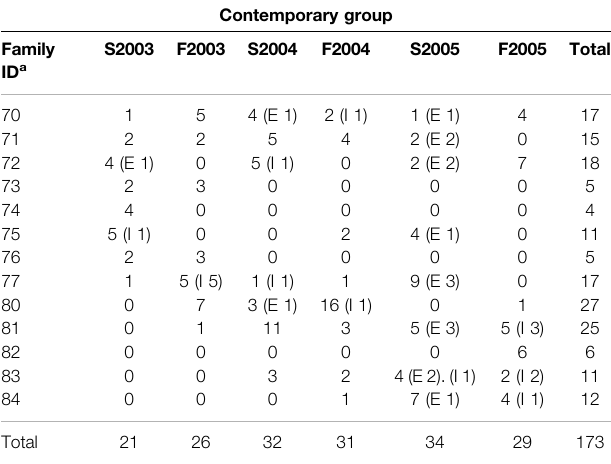
TABLE 4 | Frequency table of family distribution across BYS contemporary groups from animals evaluated for feed ef fi ciency in a previous study (Amen, 2007).